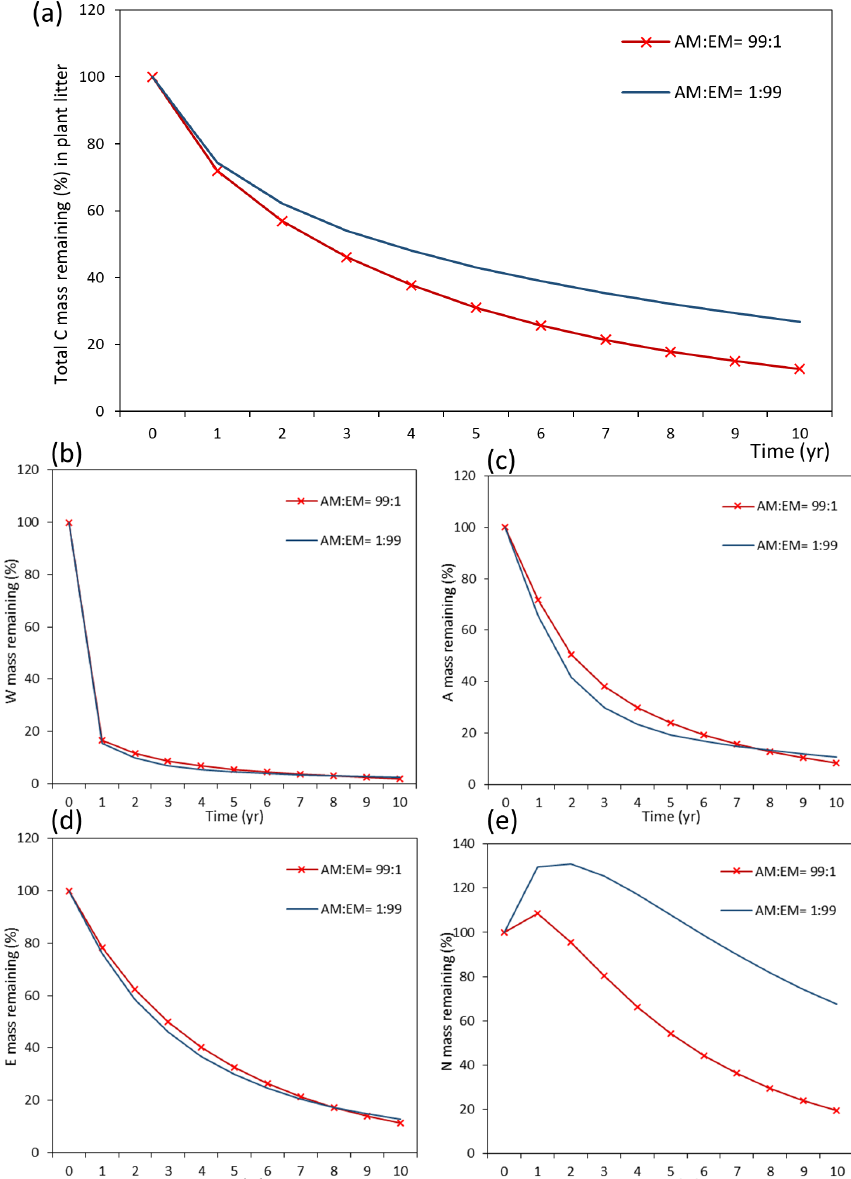
Figure 9. Dynamics of plant litter decomposition in AM-dominant vs. EM-dominant environments. (a) Decomposition of total carbon mass from plant litter. (b, c, d) The dynamics of C remaining from labile carbon components ( W – water-soluble C fraction, E – ethanol-soluble C fraction, A – acid-hydrolysable C fraction). (e) Dynamics of carbon remaining from recalcitrant C component ( N – non-hydrolysable